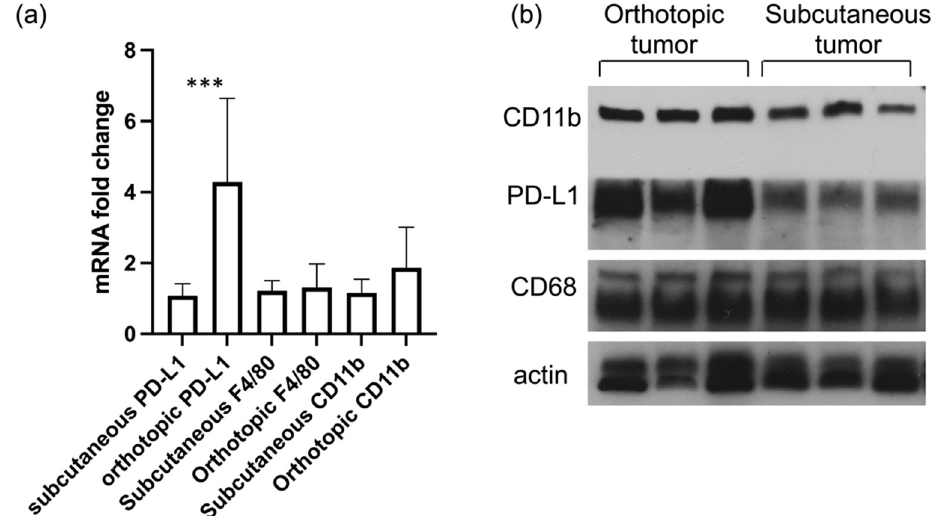
Figure 4. mRNA levels of PD-L1, F4/80, and CD11b in subcutaneous and orthotopic ID8-Defb29- VEGF tumors ( n = 8, *** p < 0.005) ( a ). Immunoblots of three subcutaneous and three orthotopic ID8- Defb29-VEGF tumors showing expression levels of CD11b, PD-L1, and CD68 ( b ). Actin was used as loading control.